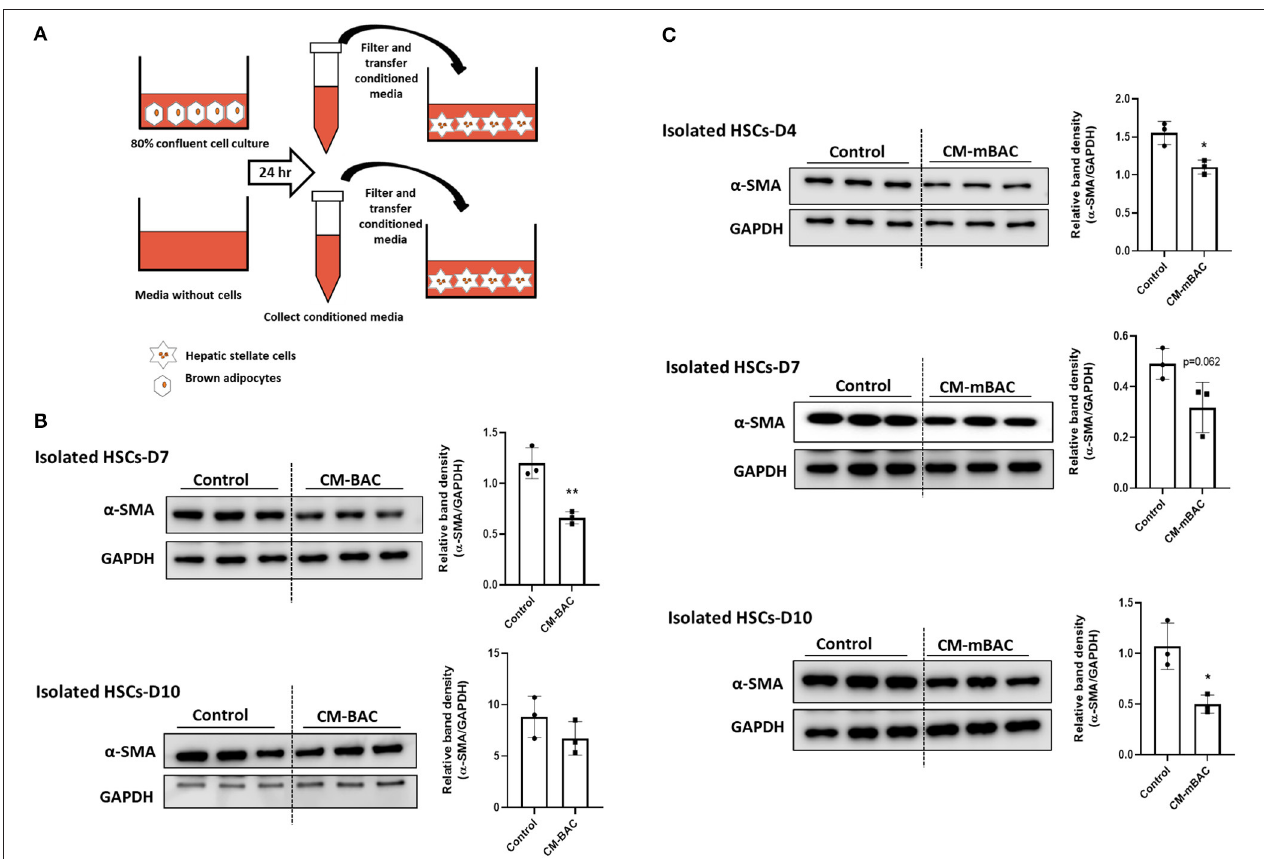
FIGURE 4 | Conditioned media from brown adipocytes inhibited HSC activation. HSCs were isolated from WT mice. At day 4, day 7, and day 10, HSCs were cultured with conditioned media from brown adipocytes (CM-BAC) or differentiated brown adipocytes (CM- mBAC) for 24h. CM-BAC was collected after 24h from brown adipocytes grown to 70–80% confluence. CM-mBAC was collected after culture of fully differentiated brown adipocytes for 24h. (A) Schematic description of HSCs culture with CM-BAC. After 24h of culture with CM-BAC (B) or CM-mBAC (C) HSCs were collected and subjected to western blotting for α -SMA. Statistically significant differences were determined by Student’s t- tests. * p < 0.05, ** p <